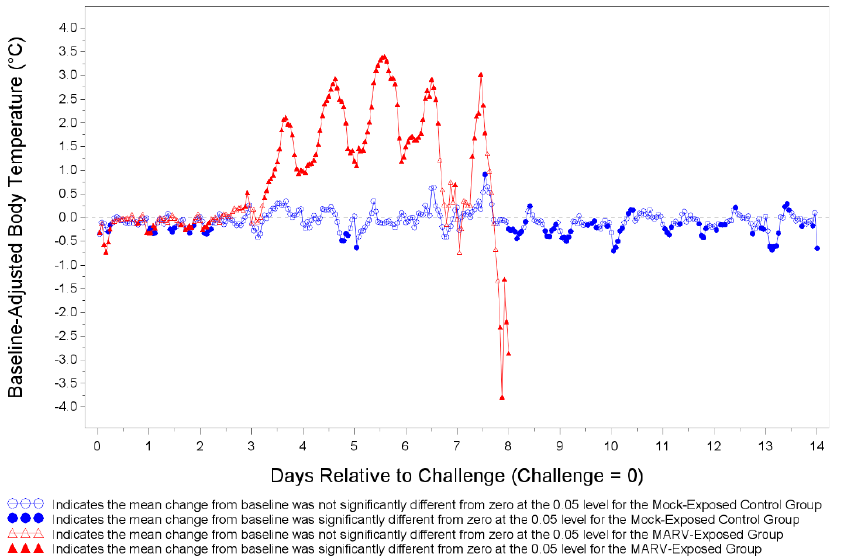
Figure 5. Least Square Mean Plot for Shift from Baseline Body Temperature (°C) for Mock-exposed and MARV-exposed Animals. Prior to challenge all NHPs were implanted with DST micro-T temperature loggers. Body temperature was recorded every 15 min. Body temperature was analyzed based on hourly averages of the pre-challenge baseline and baseline-adjusted post-challenge data. Baseline-adjusted post-challenge hourly averages were used to correct for circadian or diurnal rhythms. Days 15 through 28 for mock-exposed animals are not plotted.